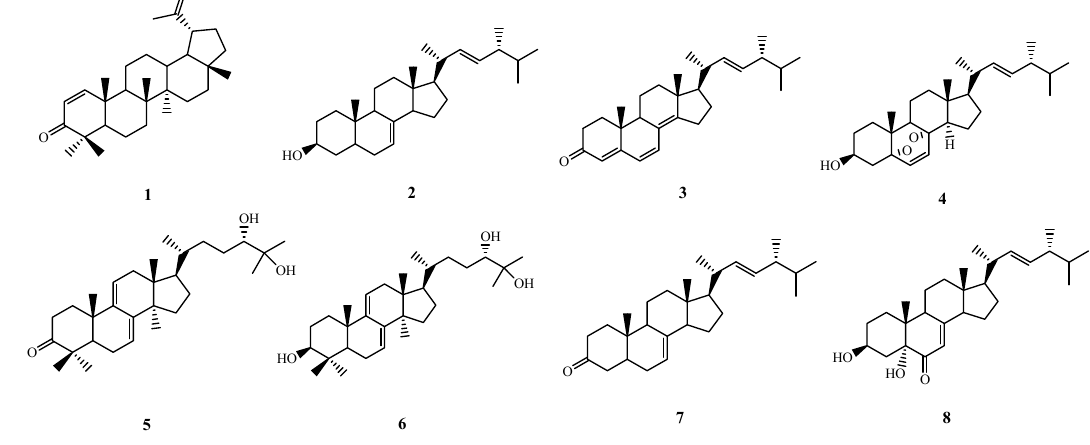
Figure 1. Structures of purified compounds 1 – 8 .